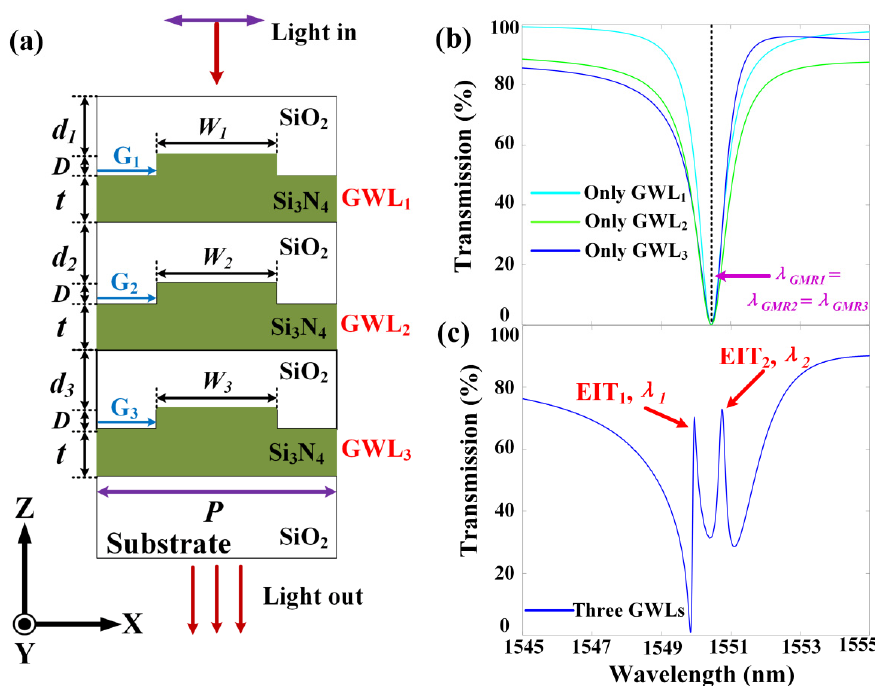
Figure 1. ( a ) Schematic diagram of the guided-mode resonance (GMR) system with three grating waveguide layers (GWLs); the geometric parameters are d 1 = 630 nm, d 2 = 690 nm, d 3 = 690 nm, D = 200 nm, t = 900 nm, W 1 = W 2 = W 3 = 400 nm, period P = 809 nm; ( b ) Transmission spectra of only GWL 1 or